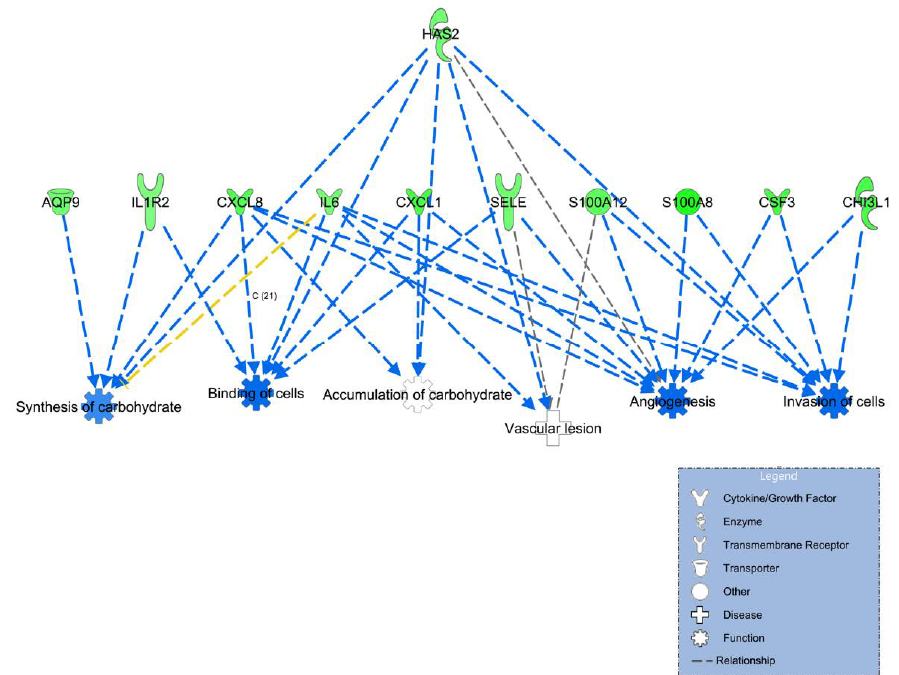
Figure 1. Pathway or network analysis derived from the differentially expressed genes identified by next-generation RNA sequence technology (RNA seq) between venous samples of control patients and those of patients with varicose vein. N = 5 for each group.